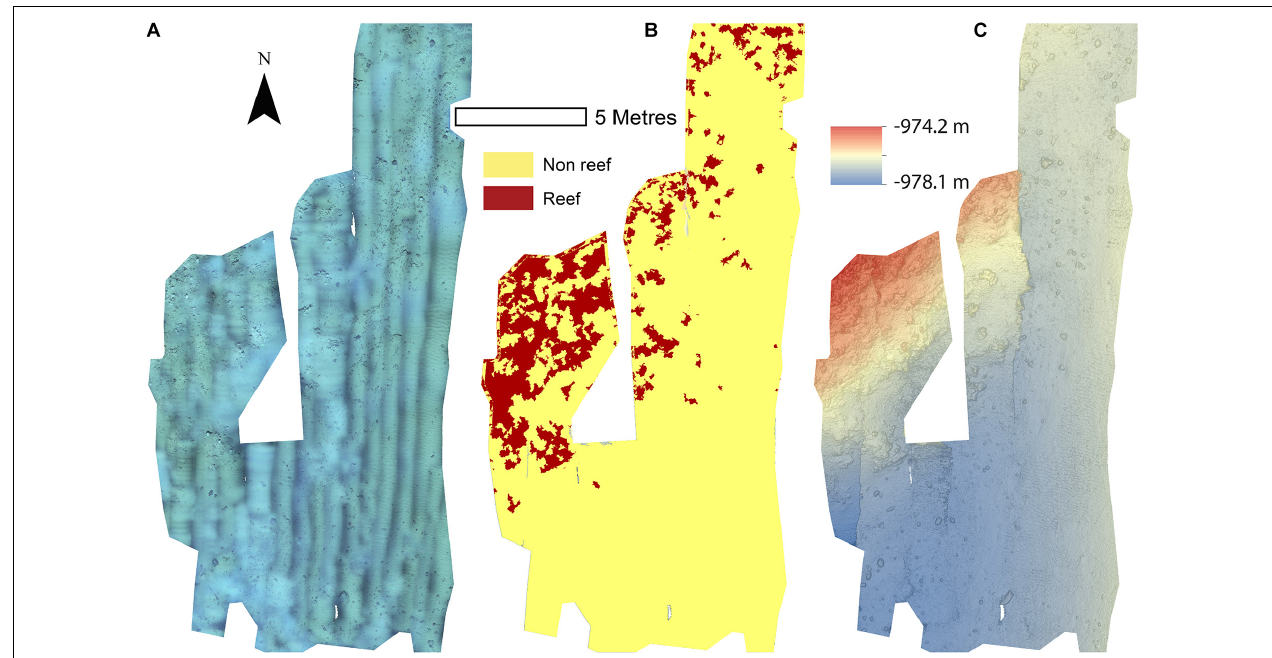
FIGURE 4 | Mosaics of Site C. (A) Orthorectified photomosaic; (B) Classified substrate map; (C) Digital elevation model.